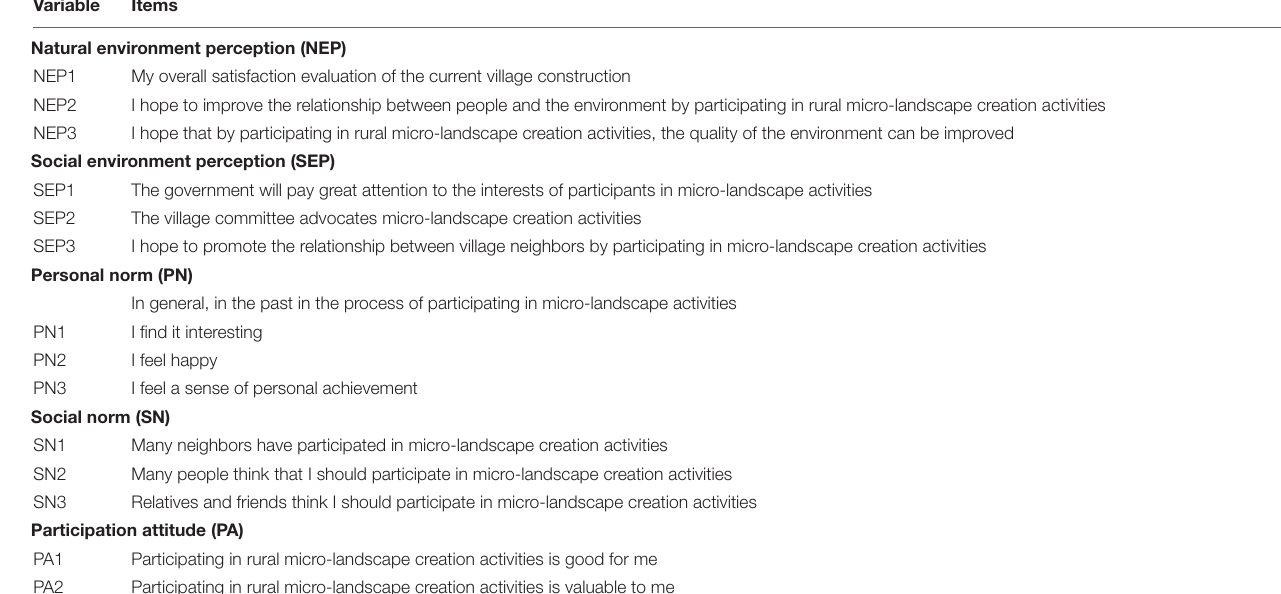
TABLE 3 | A survey project on villagers’ participation in rural micro-landscape